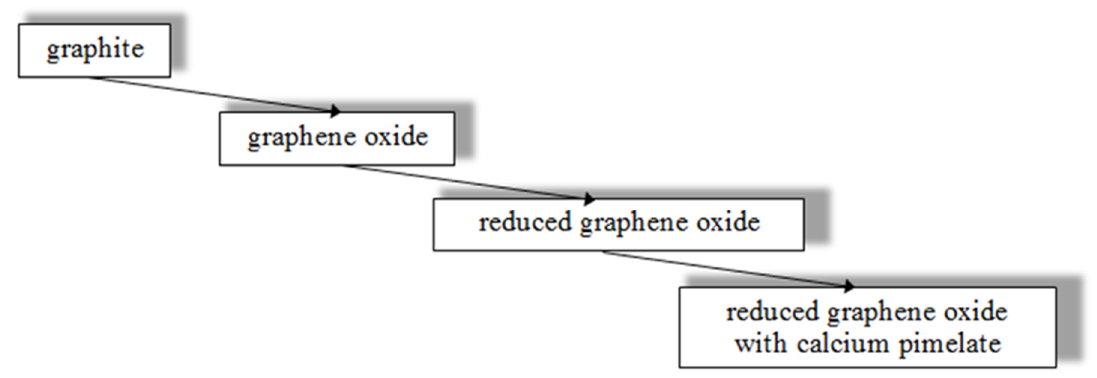
Figure 1. Scheme for preparation of functionalised reduced graphene oxide.